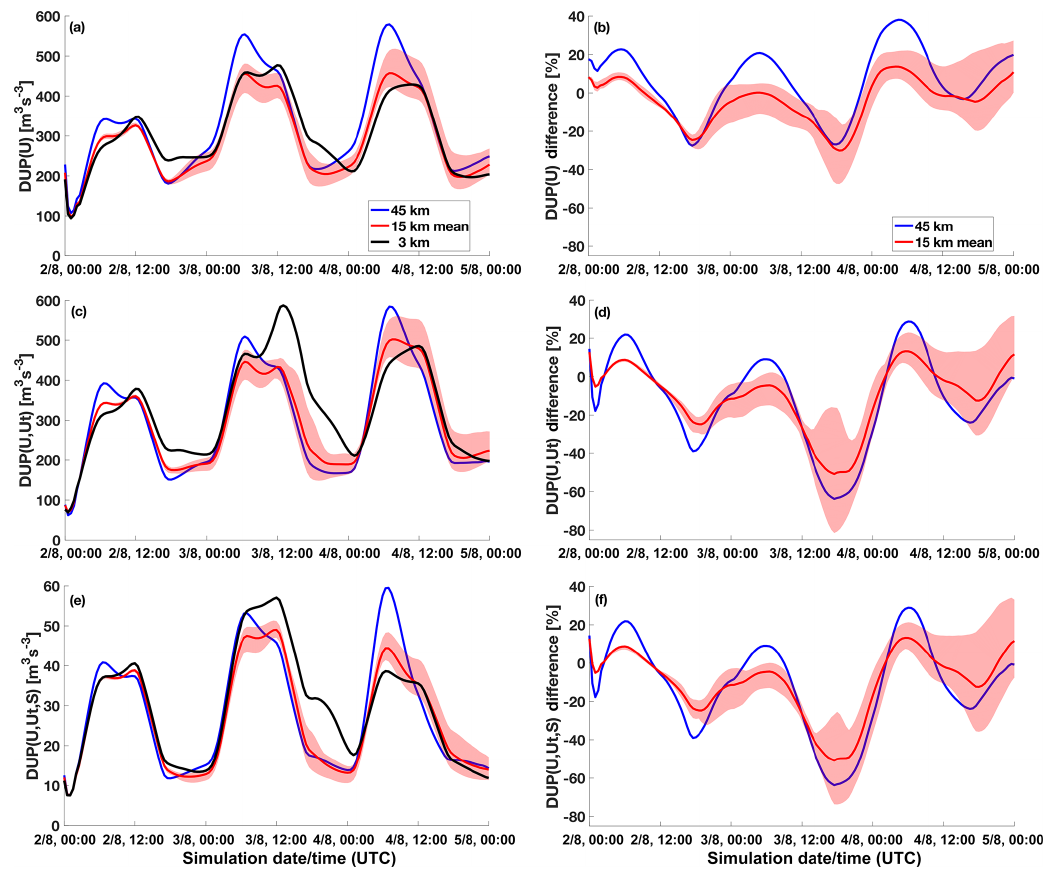
Figure 4. The spatially averaged dust uplift potential for (a) DUP( U ), (c) DUP( U,U t ), and (e) DUP( U,U t ,S ) for the 45km (blue), 15km mean (red), and 3km (black) simulations with the maximum and minimum spread across the 15km simulations indicated in light red shading. Note that there is a change in scale in the ordinate in panel (e) . (b, d, f) The percent difference between the 3km convection-permitting simulation and the simulations employing cumulus parameterizations for the different DUP